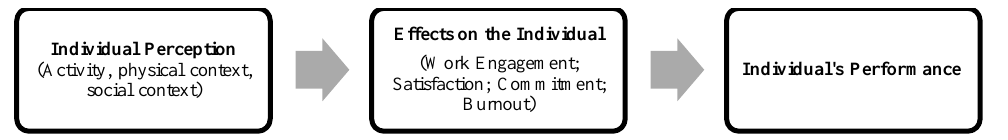
Source: Adapted from Borgogni et al., 2009; Borgogni et al., 2010; Johns,